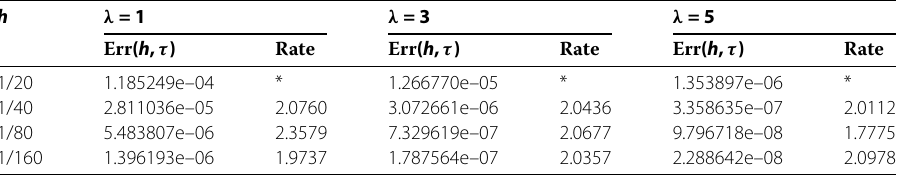
Table 8 Numerical errors and convergent orders with α = 0.5, β = 1.5, T = 1, when q = 4, τ = h